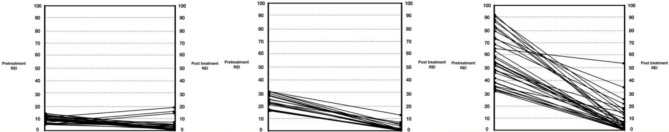
Pre-treatment and post-treatment respiratory event index (REI) values for the participants in the study. The left graph is mild (REI < 15); middle is moderate (REI 15–30); and right is severe (REI > 30).